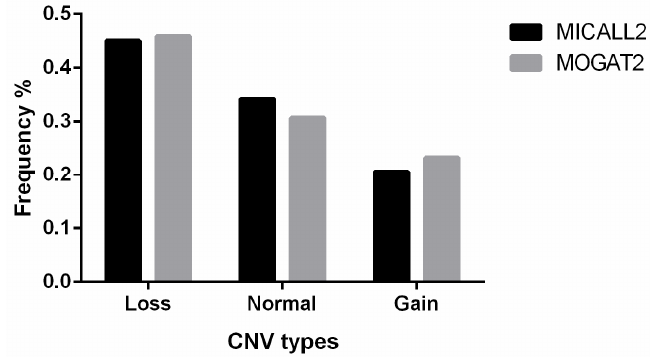
Figure 1. MICALL2 and MOGAT2 gene CNV proportions in analyzed Ashidan yaks.